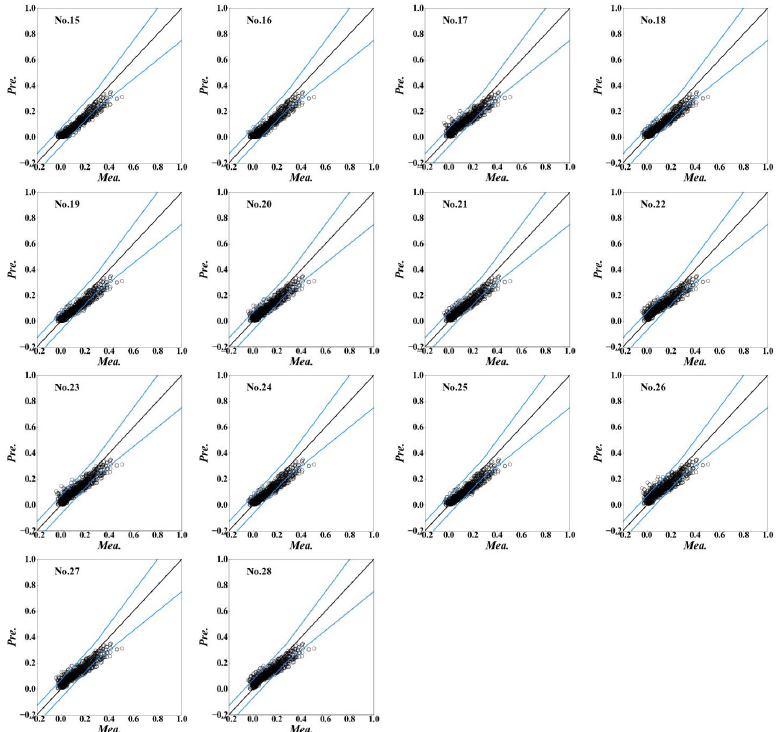
Figure A1. Comparisons of the combined wake models with the cosine ‐ shaped distribution.